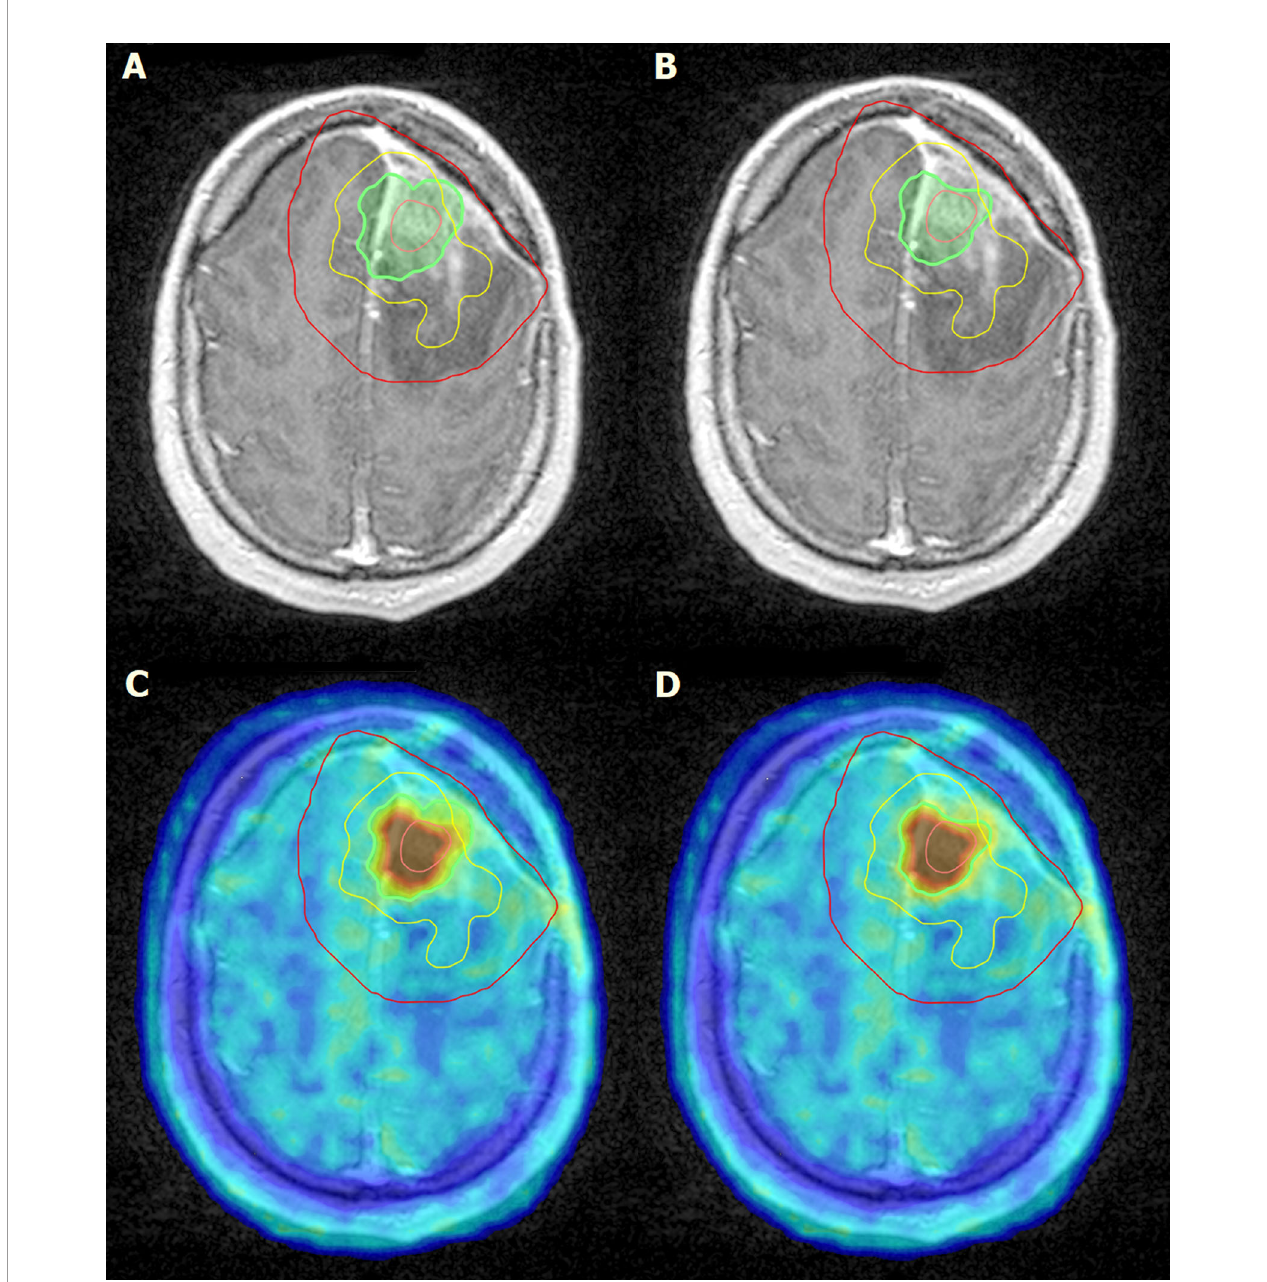
FIGURE 4 | Left frontal post craniotomy status. Inhomogeneous, mainly centrally, moderate enhancement of contrast material is observed on T1-weighted post contrast MRI images. The lesion in the left hemisphere is surrounded by edema (A, B) . Irregularly shaped intense, focal 18F-FDOPA accumulation can be detected on the left side of the brain frontally, above the level of lateral ventricles (C, D) . Pink line, GTV; green line, BTV 1.7 (A, C) ; green line, BTV 2.0 (B, D) ; red line, PTV; yellow line,